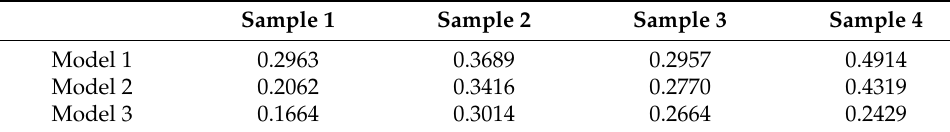
Figure 7. Comparison results of the three models and the real results: ( a ) sample 1; ( b ) sample 2; ( c ) sample 3; ( d ) sample 4. Table 7. Variance of the difference between the predicted value and real